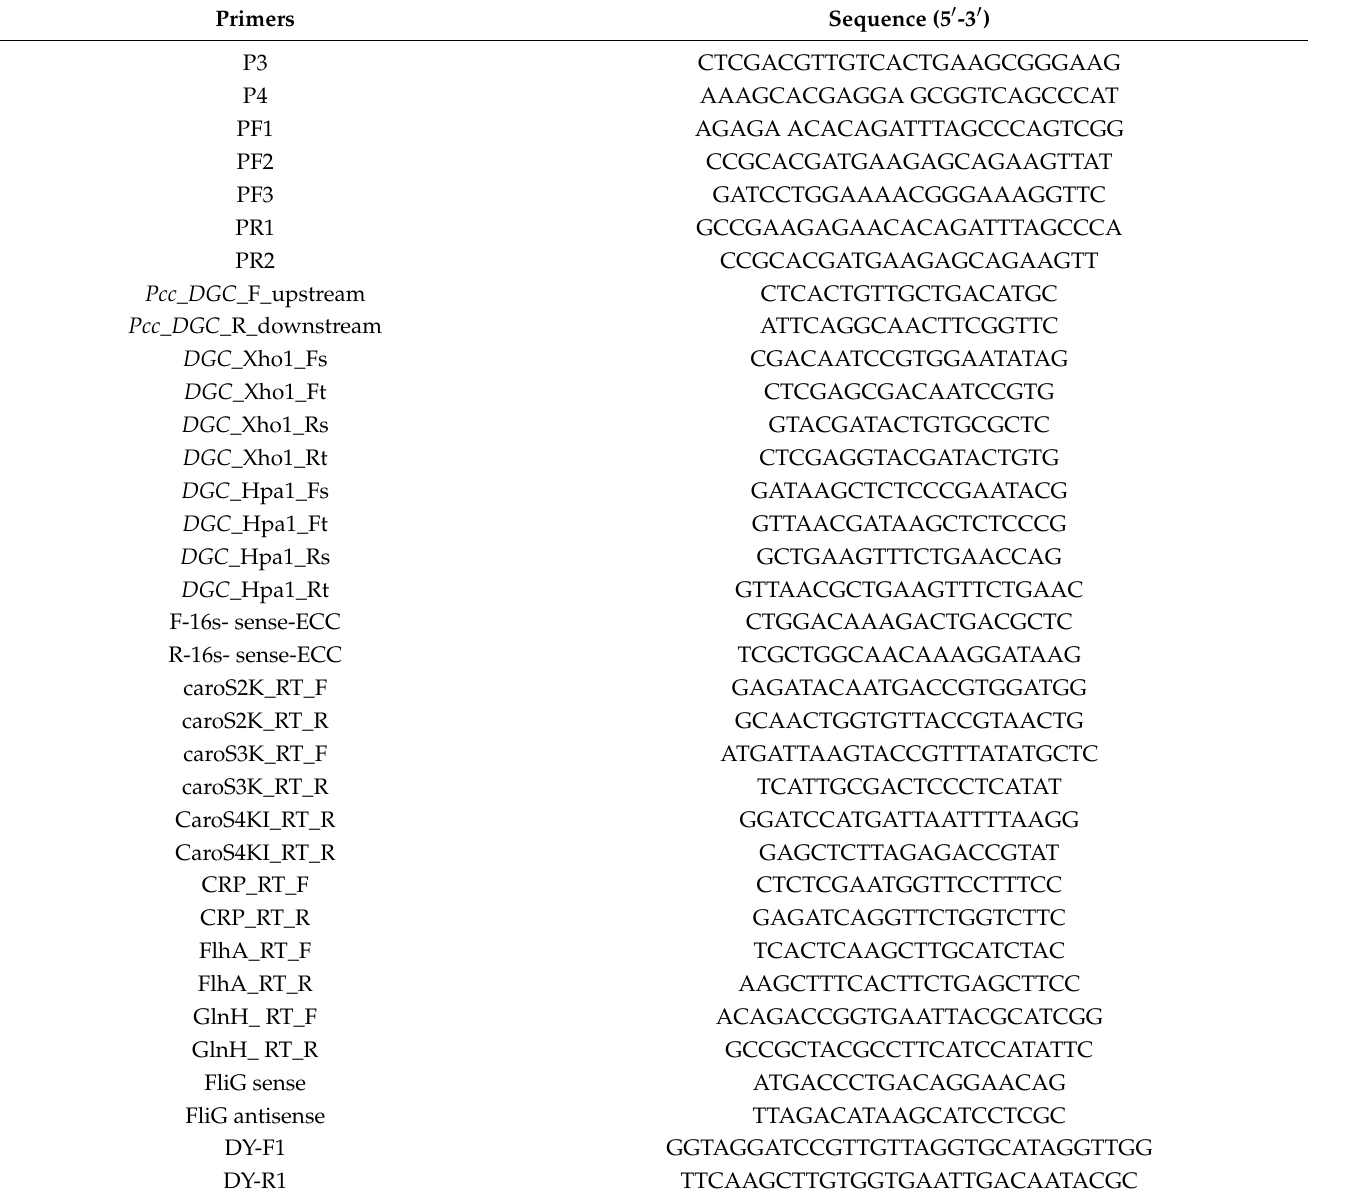
Table 3. Primers used in this